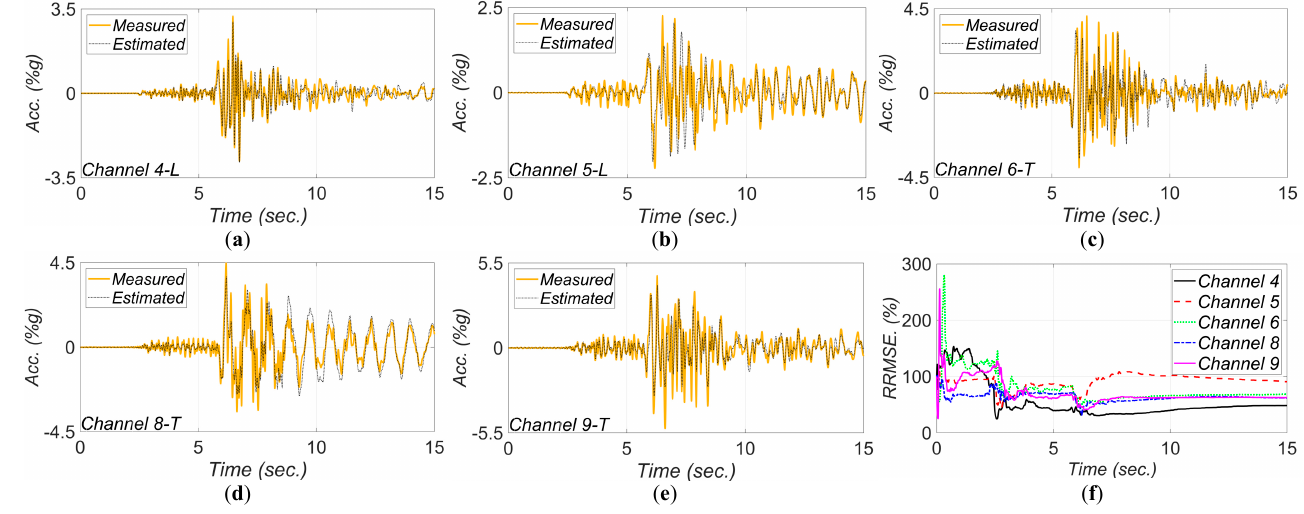
Figure 18. Comparison between measured and estimated (from updated model) responses at different measurement channels for 2004 IslaVista earthquake: ( a ) channel 4, ( b ) channel 5, ( c ) channel 6, ( d ) channel 8, ( e ) channel 9. Part ( f ) is the corresponding RRMSEs.